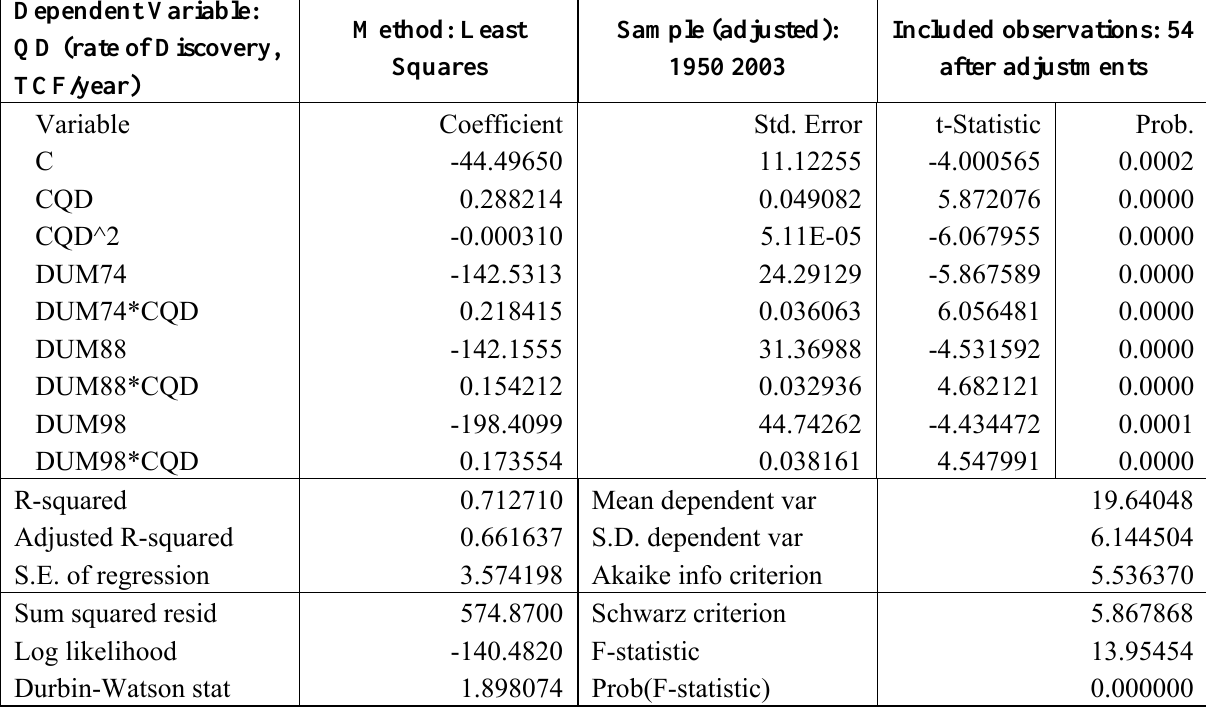
Table 6. OLS results on a four cycle Hubbert